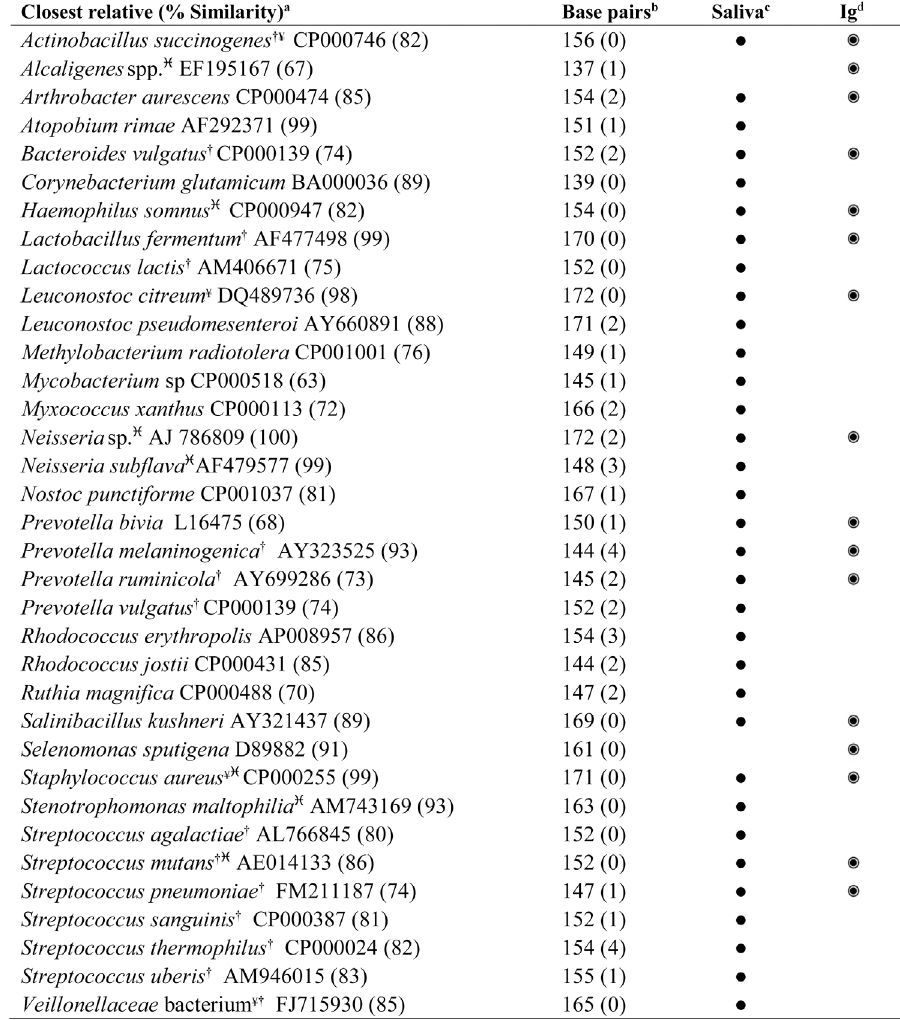
Fig 2. Major phylotypes identified by 16S rRNA gene sequencing from complete salivary and. Immunoglobulin-selected fractions. a based on EMBL database searches; b the number of ambiguous bases is given in parenthesis;. c identified in salivary microbiota profile; d identified in the immunoglobulin (Ig) recognized positively selected fraction; † known oral bacterium; ¥ multiple bands noted in same lane; ♓ identified by sequencing colonies from culture of pooled positively selected fractions on blood